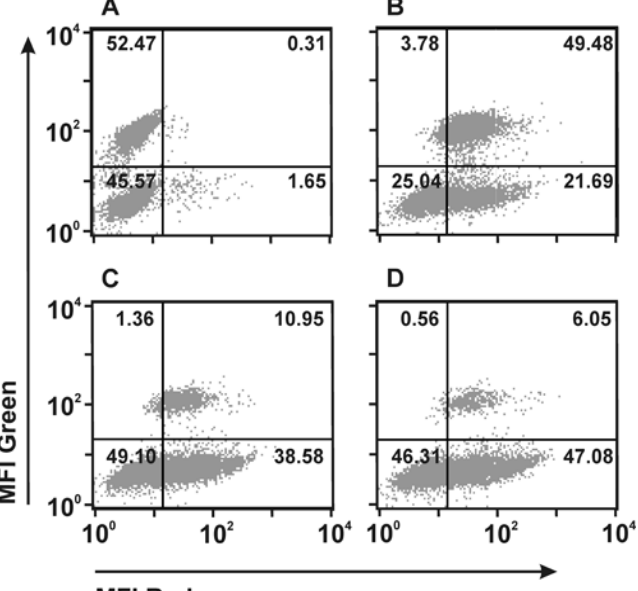
Figure 5. Triplebody HLA-ds16-hu19 preferentially binds antigen double-positive cells by virtue of dual-targeting. SEM cells (double-positive for CD19- and HLA-DR) were loaded with the fluorescent label Calcein (green) and mixed with unlabeled HUT-78 cells (single-positive for HLA-DR). The mixing ratio was 1:1 for panels A and B and 1:10 or 1:20 for panels C and D , respectively. Mixtures were incubated with phosphate buffer containing albumin (PBA, panel A ) or the sctb (B – D ). Fluorescent labeled SEM cells free of decorating sctb were detected in the upper left quadrant, the unstained free HUT-78 cells in the lower left quadrant. Cells decorated with the sctb shifted to the right quadrants. Numbers represent the percentage of the cells in the respective quadrants. From Schubert 2012 [12] with